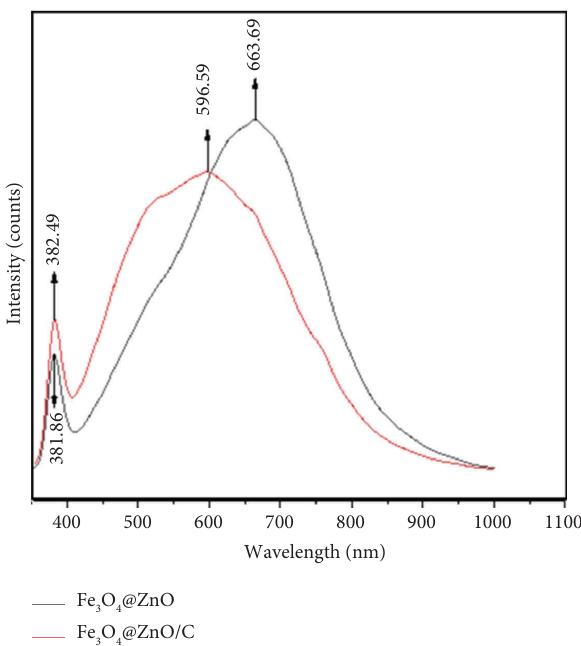
3 O 4 @ZnO nanocomposite.